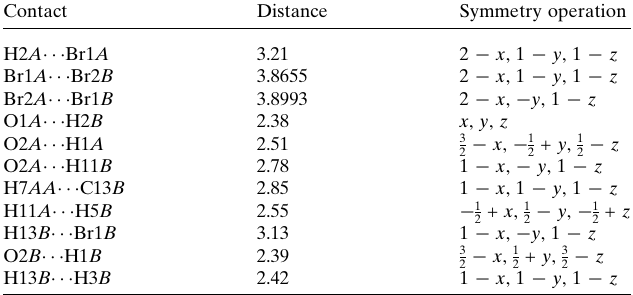
Table 2 Summary of short interatomic contacts (A˚ ) in the title compound.